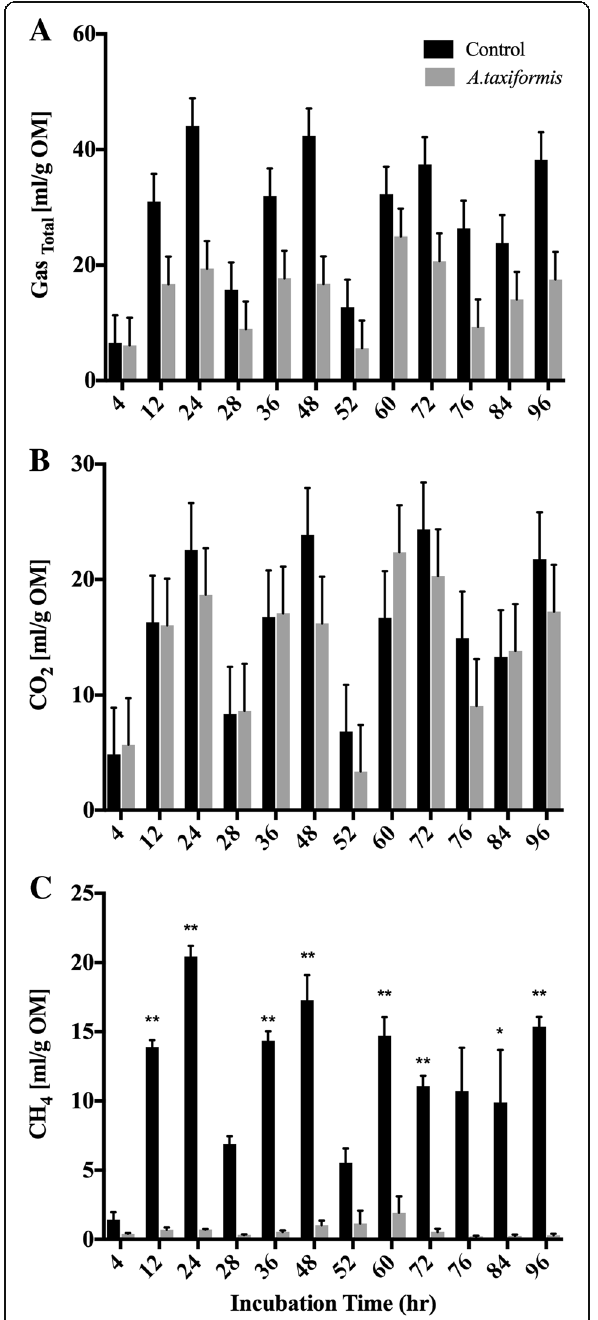
Fig. 2 Total gas, CH 4 , and CO 2 production during in-vitro fermentation. Production of total gas, CH 4 and CO 2 [ml/(g OM)] from vessels without ( n = 3) and with (n = 3) A. taxiformis as additive at 4, 12, and 24h over the course of the experiment. a Total gas production; b CH 4 production; c CO 2 production. Measurement were performed in triplicates. “ ** ” indicates significant difference ( p value ≤ 0.05), “ * ” indicates trend toward significance (0.05> p value ≤